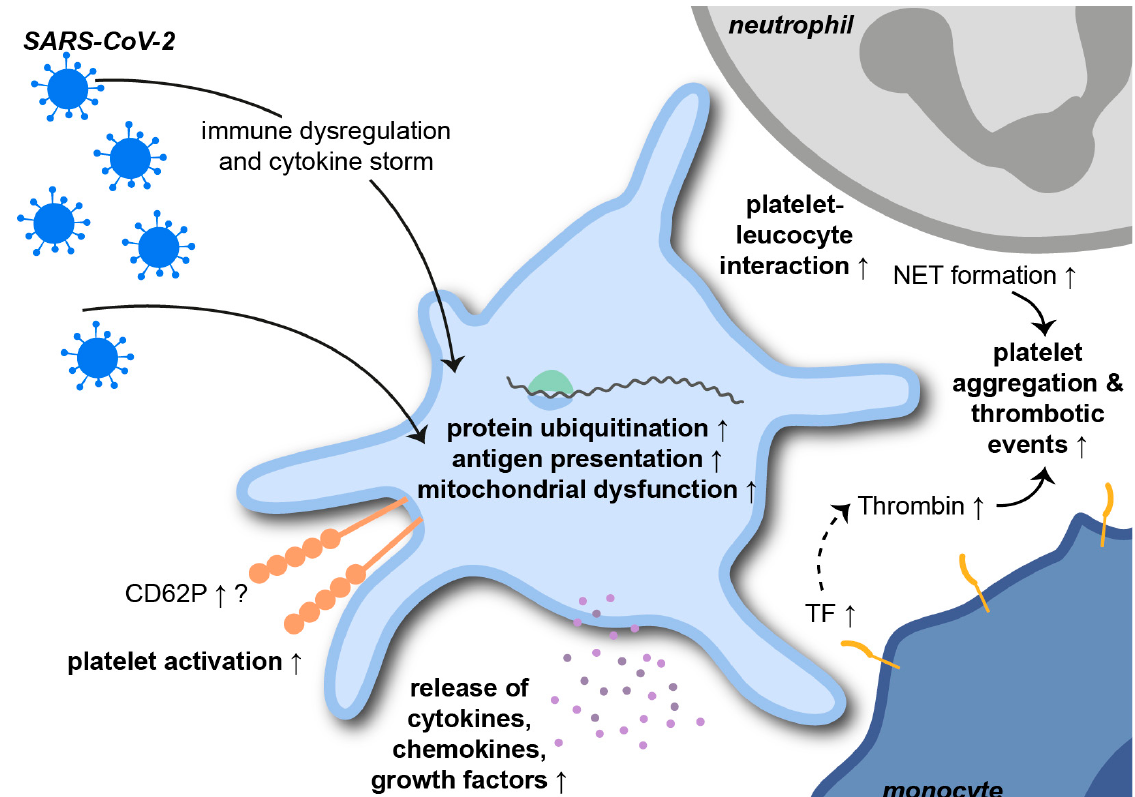
Figure 4. Platelets during SARS-CoV-2 infections. The severe acute respiratory syndrome coronavirus 2 (SARS-CoV-2) alters the platelet transcriptome towards enhanced protein ubiquitination, antigen presentation and mitochondrial dysfunction. SARS-CoV-2 infections are associated with enhanced platelet activation, resulting in increased platelet–leukocyte interactions and release of platelet-derived cytokines. NET = neutrophil extracellular trap; TF = tissue factor.